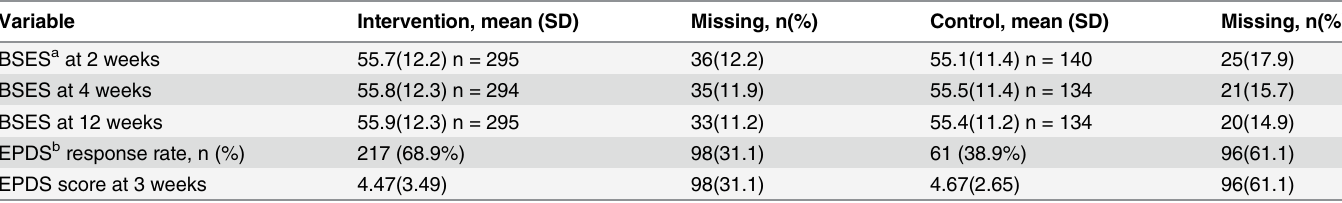
Table 5. Secondary outcomes on Breastfeeding Self-Efficacy Scale and Edinburgh Postpartum Depression